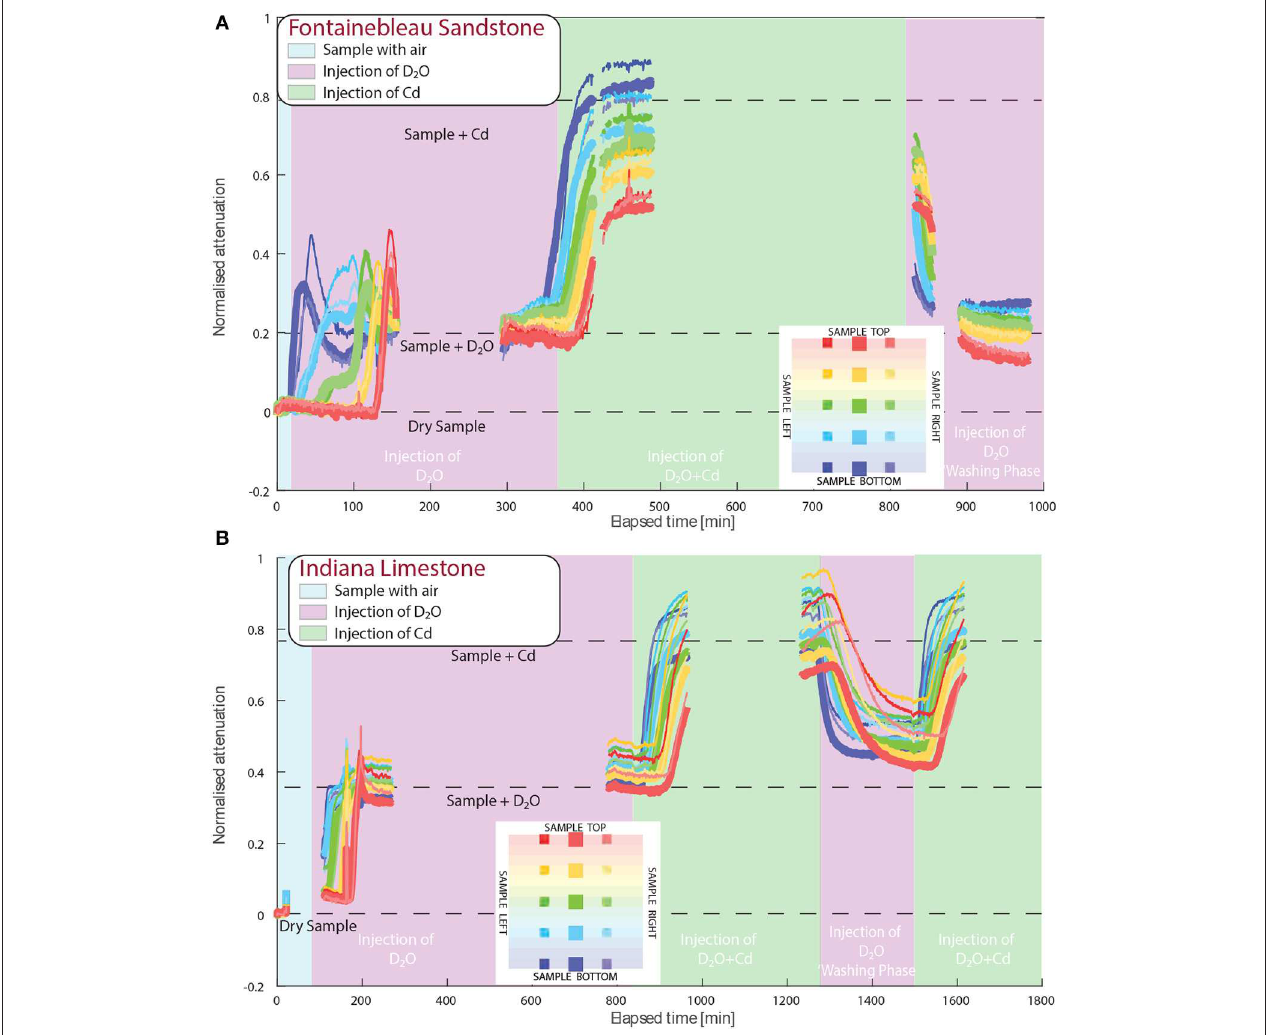
FIGURE 5 | Normalized neutron attenuation in the samples vs. time. Hiatuses in the data correspond to failures of the camera system or tomography acquisition. The different curves display different regions in the sample, as mapped in the figure inset. The central region of the sample has an increased thickness for easier visualization. (A) Fontainebleau sandstone experiment. The first injection of D 2 O shows a slight overshoot before 200 min. due to some left-over cadmium from the previous experiment still present in the tubing system. (B) Indiana limestone